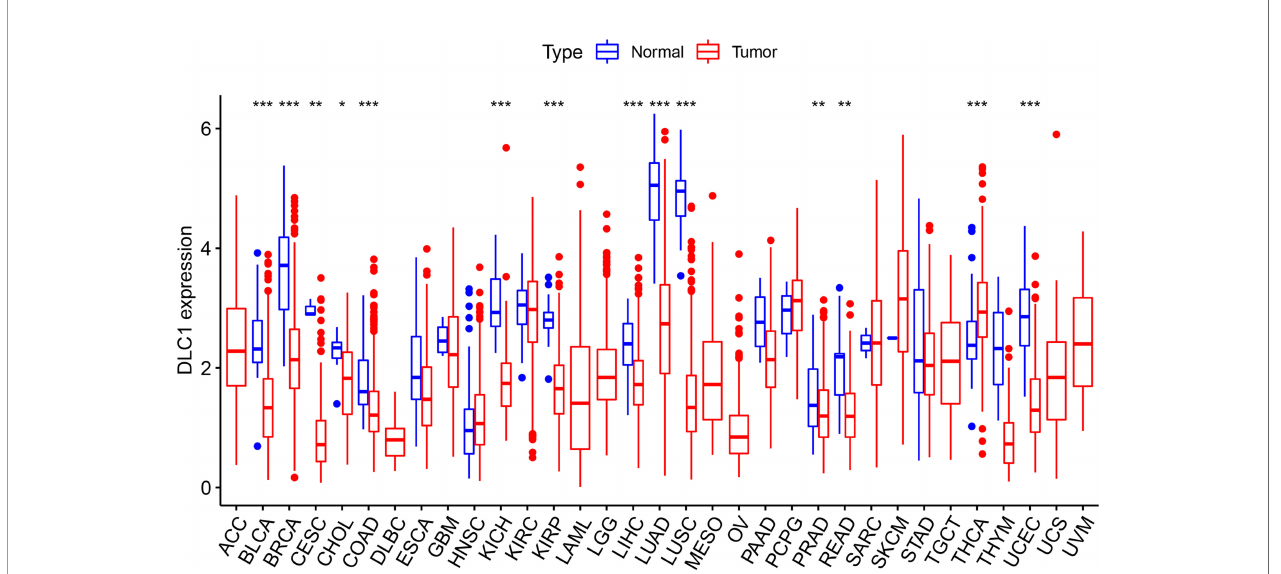
FIGURE 1 | Expression level of deleted in liver cancer 1 (DLC1) in different types of tumor and normal tissues in The Cancer Genome Atlas (TCGA) database (* P < 0.05, ** P < 0.01, *** P <